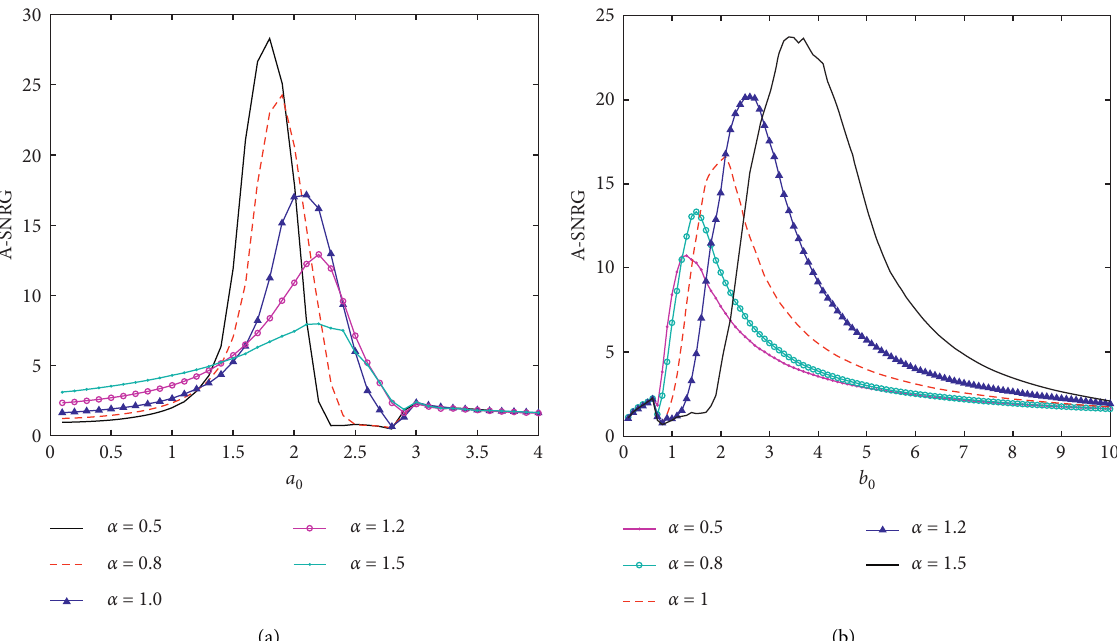
Figure 10: A-SNRG of SR with asymmetric width of potential well as a function of a potential function parameter. (a) a